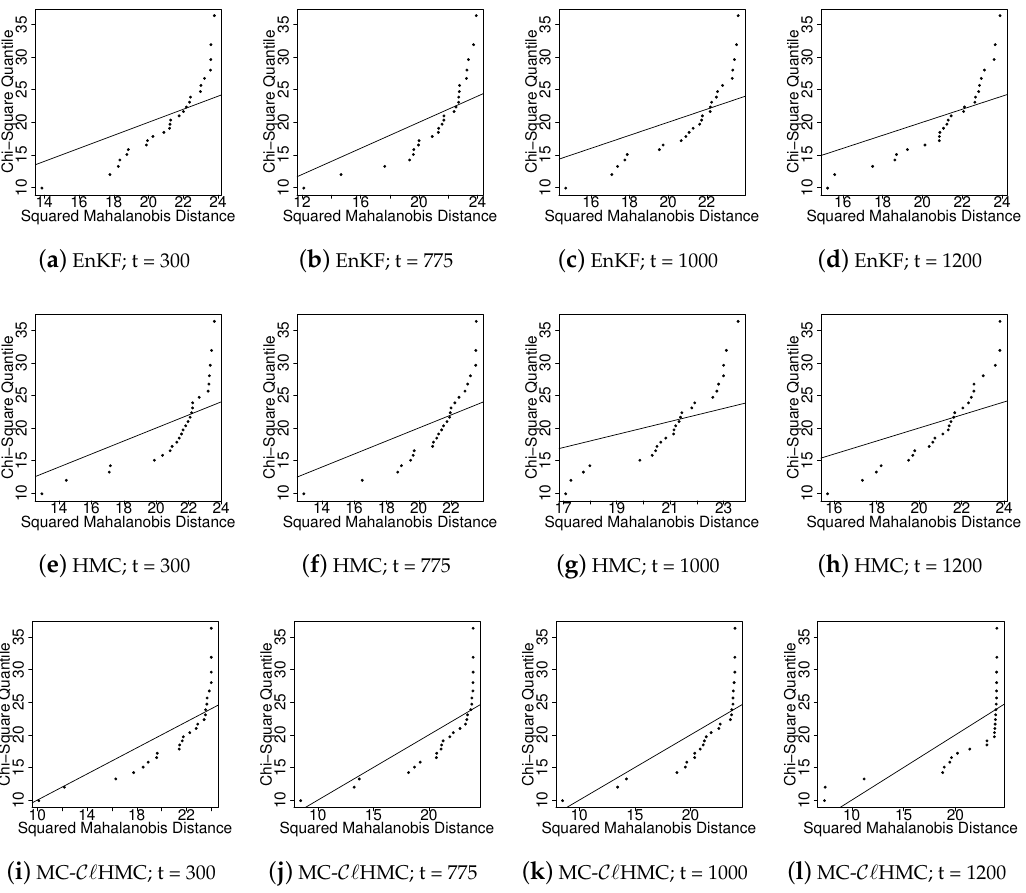
Figure 7. Data assimilation with a linear observation operator. Chi-square Q-Q plots for the forecast ensembles obtained from propagating analyses of EnKF, HMC, and MC- to times t = 300, 775, 1000, and 1200 provide a strong indication of non-Gaussianity. The filtering methodology, and the assimilation time are given under each panel. Localization is applied to the ensemble covariance matrix to avoid singularity while evaluating the Mahalanobis distances of the ensemble